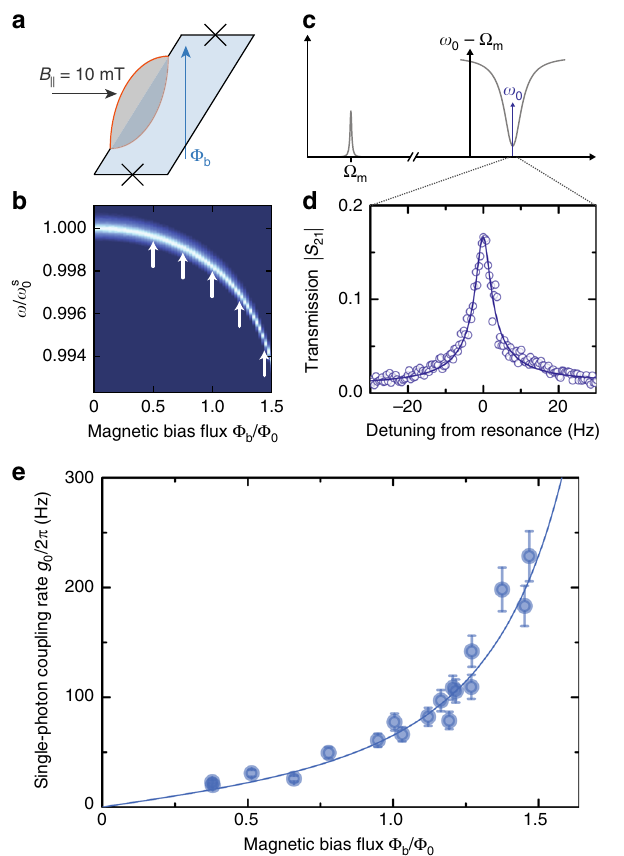
Fig. 3 Tuning the optomechanical single-photon coupling rate by changing the fl ux operating point of the SQUID. a Schematic of the applied magnetic fi eld components to the SQUID loop. The in-plane magnetic fi eld B by means of a cylindrical coil wrapped around the whole sample mounting.